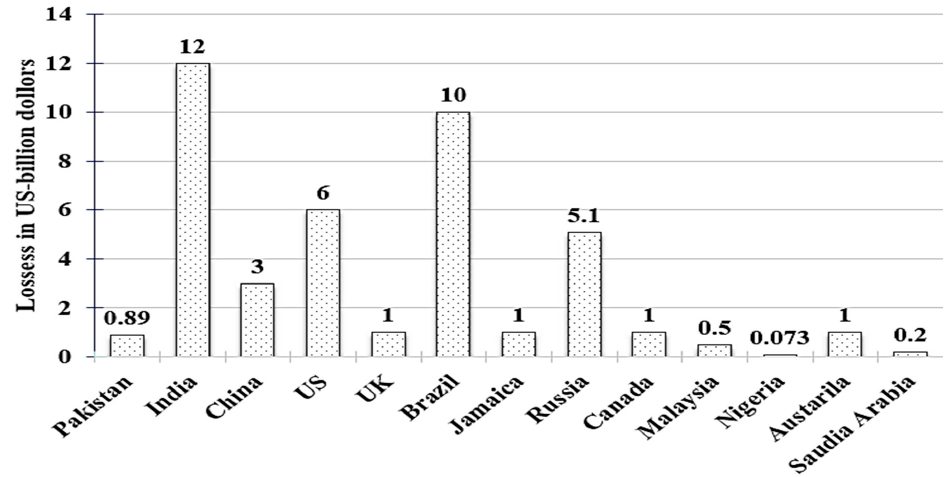
Figure 1. Nontechnical losses in different countries [3].